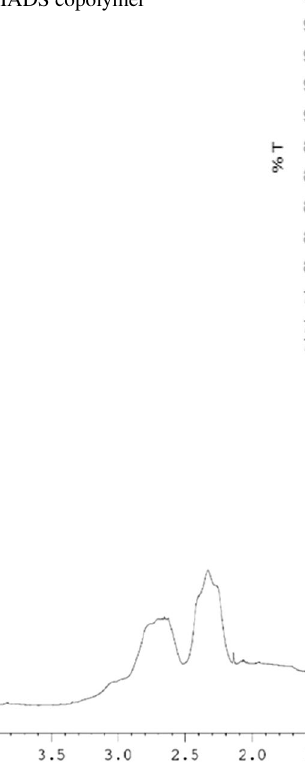
Fig. 2 FTIR spectrum of the